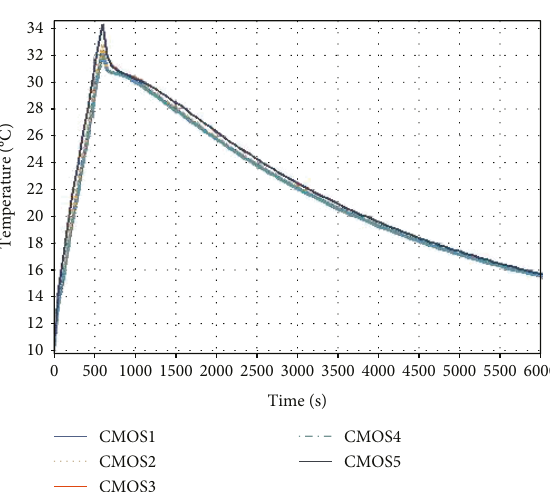
Figure 12: Temperature comparisons of the fi ve